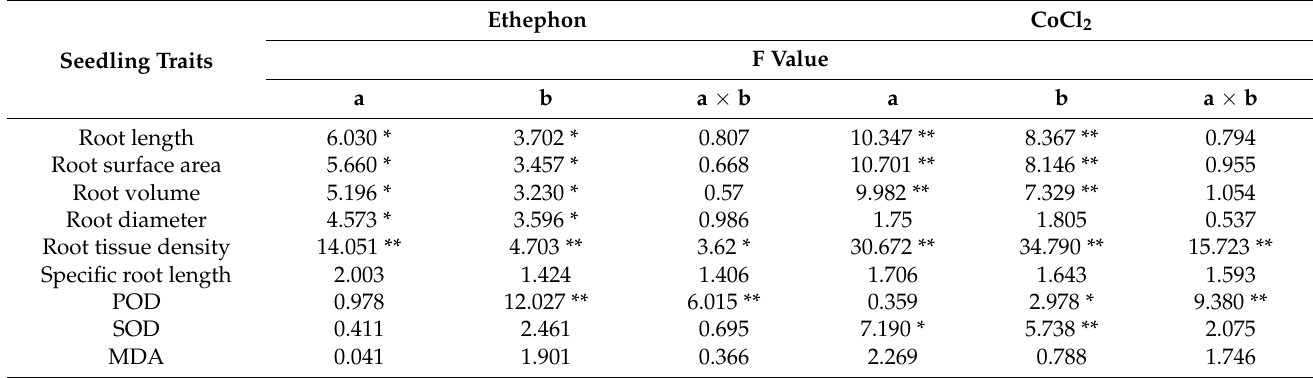
Table 1. Two-factor analysis of the influence of phosphorus-supply level and the concentrations of exogenous ethephon and CoCl 2 on the development indices of Chinese fir